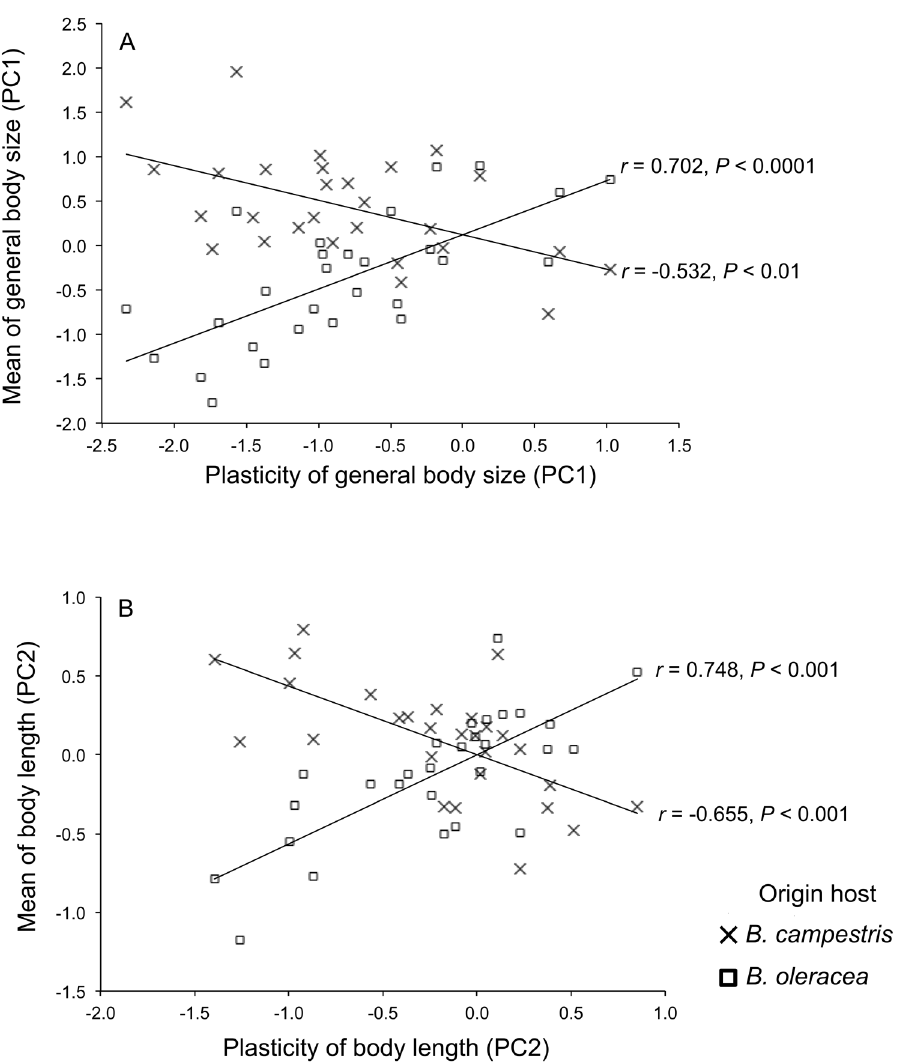
Figure 3. Relationship between trait value and plasticity of two morphological traits of Brevicorynebrassicae . (A) PC1, general body size; (B) PC2, body length. The points represent the average value per genotype.